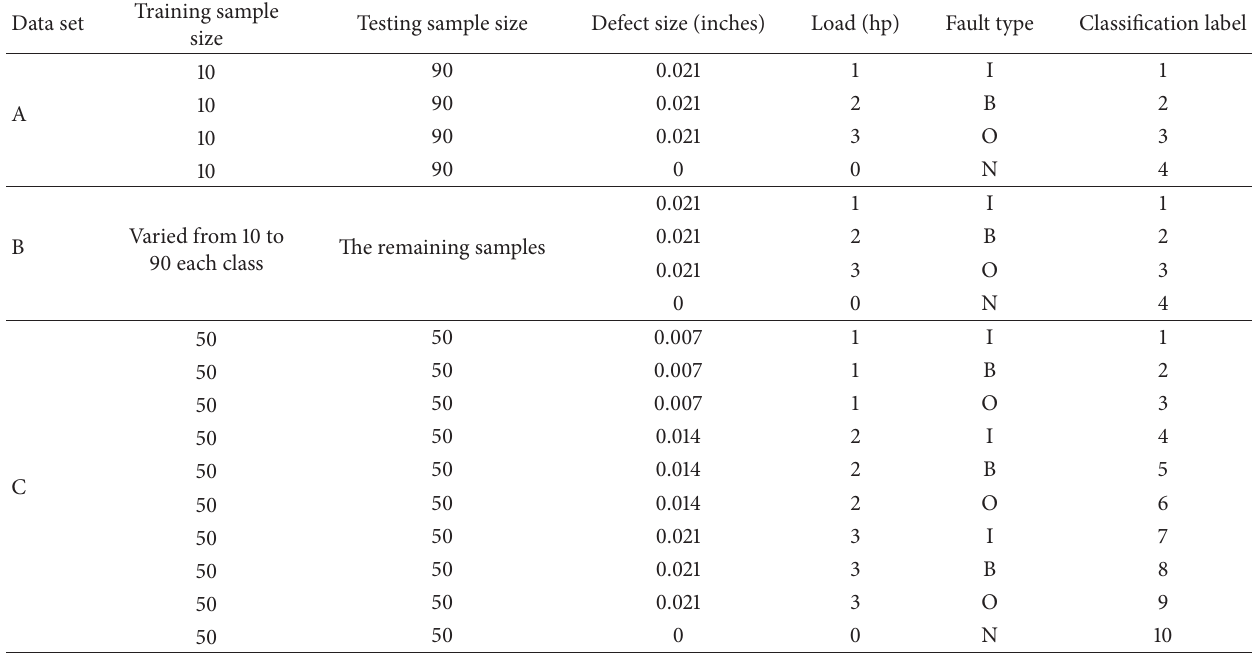
Table 1: Description of the data